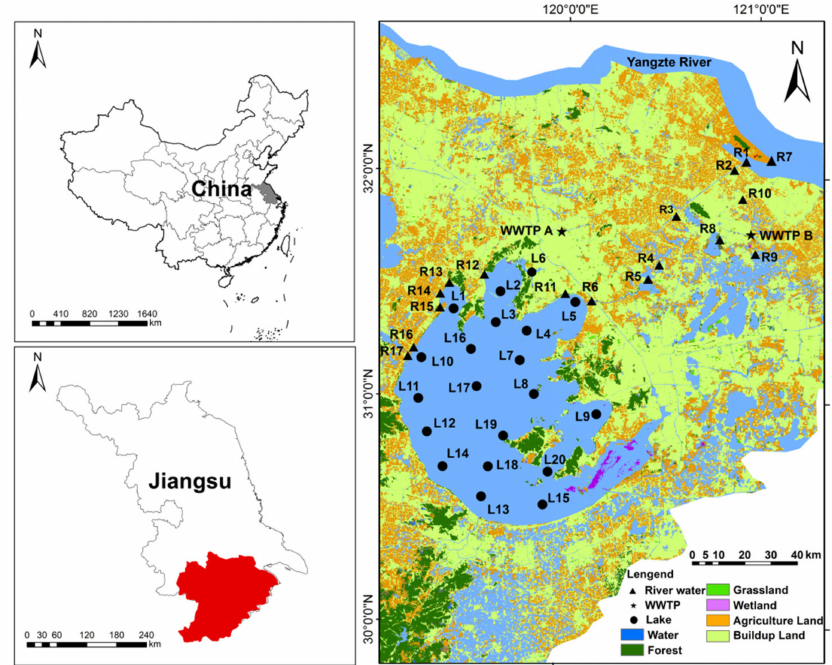
Figure 1. The land use and the location of sampling sites in the